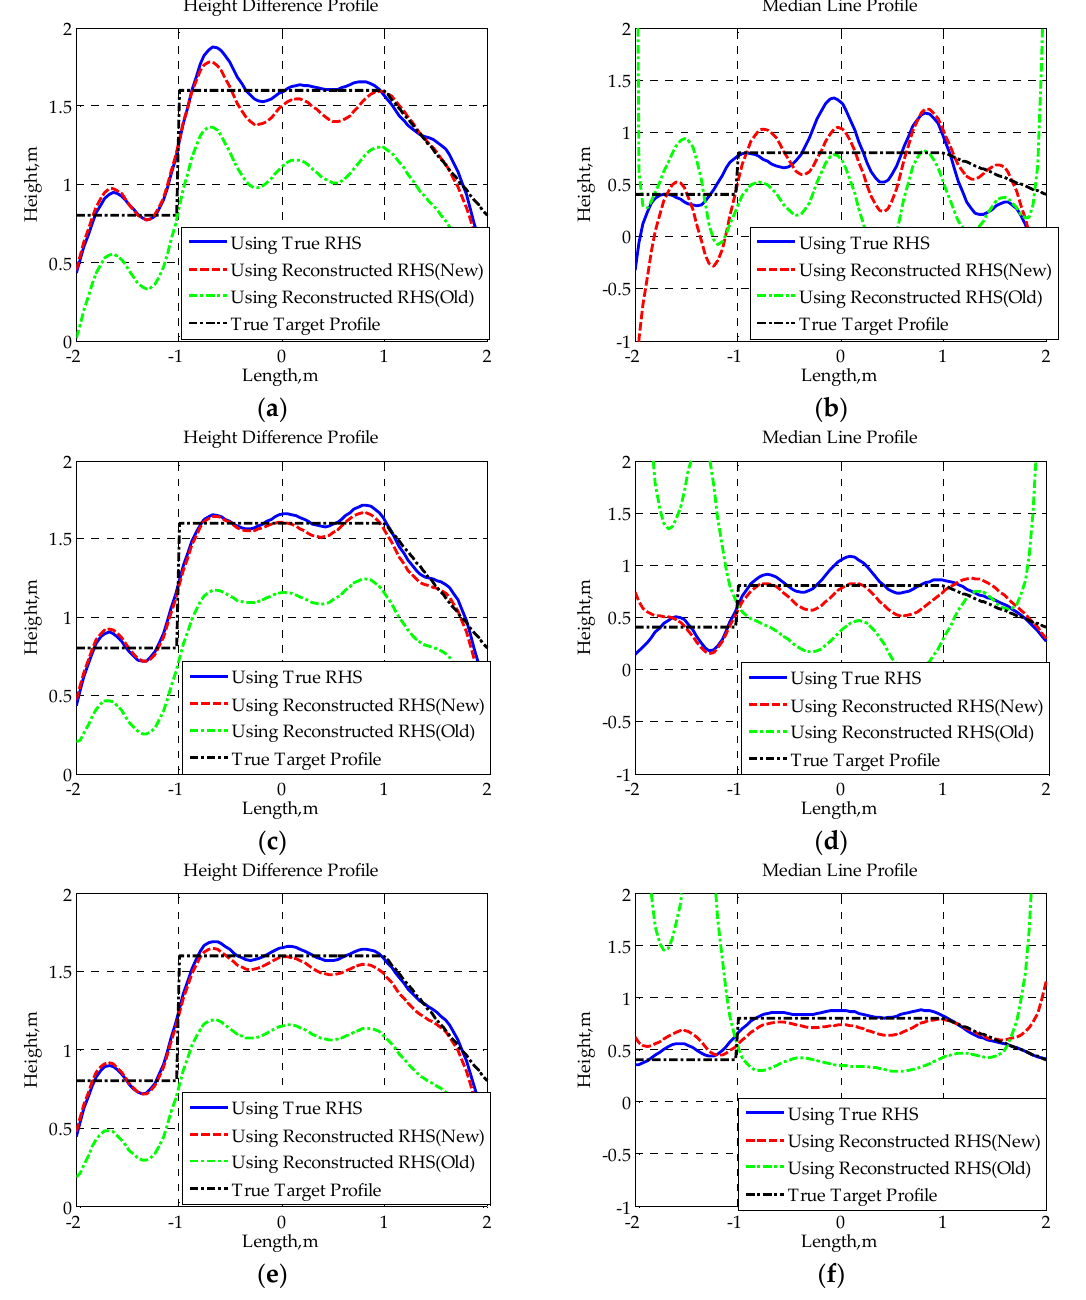
Figure 17. Shadow Inverse Synthetic Aperture Radar (SISAR) imaging results of signals with: ( a , b ) signal-to-noise ratio (SNR) = 0 dB; ( c , d ) SNR = 10 dB; ( e , f ) SNR = 20 dB. The height difference profiles are in the left column and the median line profiles are in the right column.